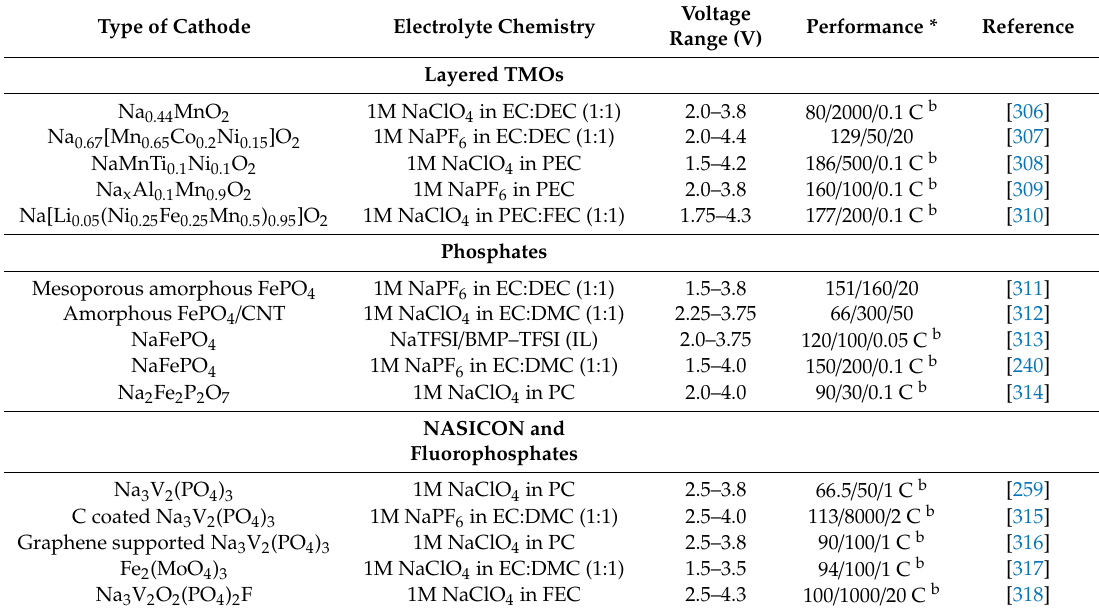
Figure 14. Structural characterization and electrochemical performance analysis of PI / MWCNT composite as a cathode in SIBs. ( a ) SEM images demonstrating a 3D network of fibers as the morphology of the PI / MWCNT fibers. ( b ) TEM image exhibiting the fiber network in greater detail. ( c ) XRD pattern of the PI / MWCNT fiber composite in comparison with its precursors with the characteristic peaks being visible. ( d ) Schematic reaction map depicting the synthesis of the PI / MWCNT nanocomposite. ( e ) Galvanostatic charge–discharge graphs of the PI / MWCNT composite as cathode in the SIB. ( f ) Capacity retention for the composite cathode for both charge and discharge cycles. ( g ) Rate performance of the PI / MWCNT cathode demonstrating almost all capacity retention when the rate is switched back to lower values. Copyright 2018, American Chemical Society. Table 5. High performance cathodes for